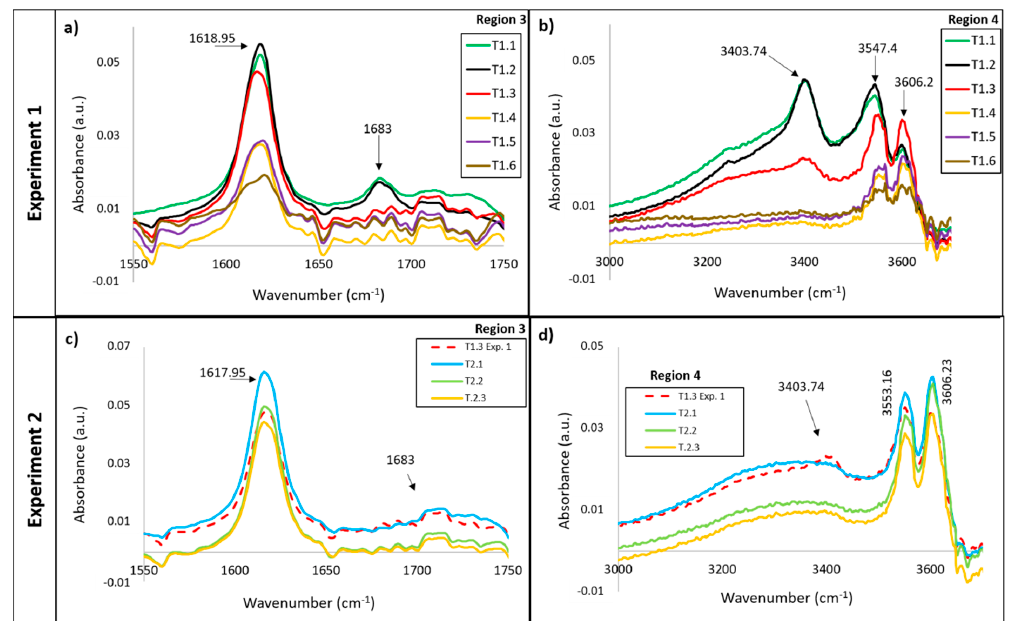
Figure 5. Image of the vibration’s bands of H 2 O molecule for the different testing points for both thermal treatments, showing the amount of water at the different testing points. ( a ) Infrared spectrum between 1550–1750 cm − 1 for Experiment 1; ( b ) Infrared spectrum between 3300–3700 cm − 1 for Experiment 1; ( c ) Infrared spectrum between 1550–1750 cm − 1 for Experiment 2; ( d ) Infrared spectrum between 3300–3700 cm − 1 for Experiment 2.